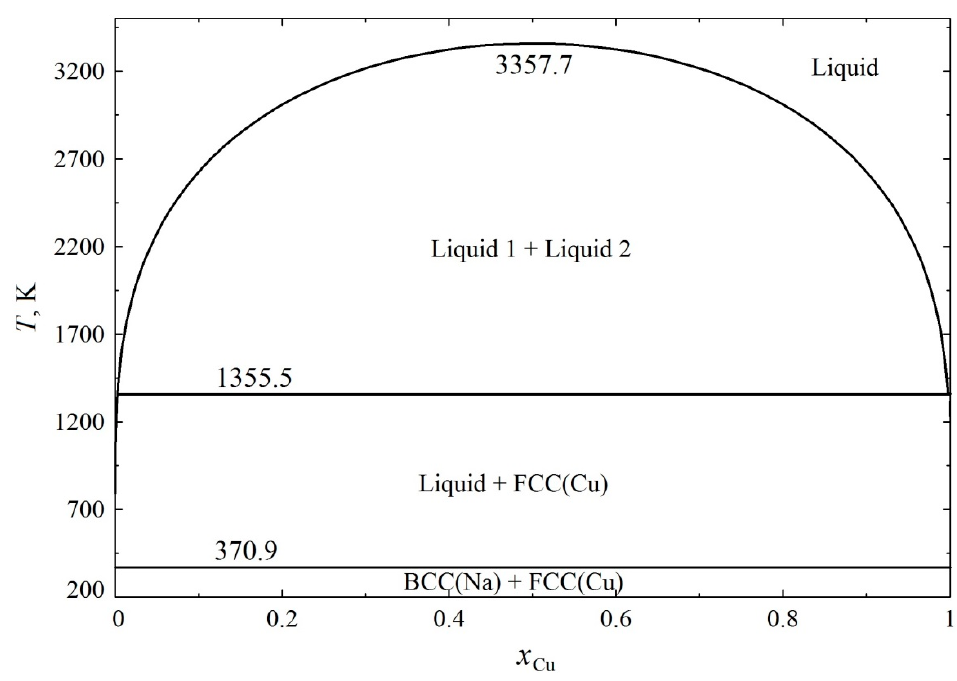
Figure 2. General view of the calculated phase diagram of the Na-Cu system.